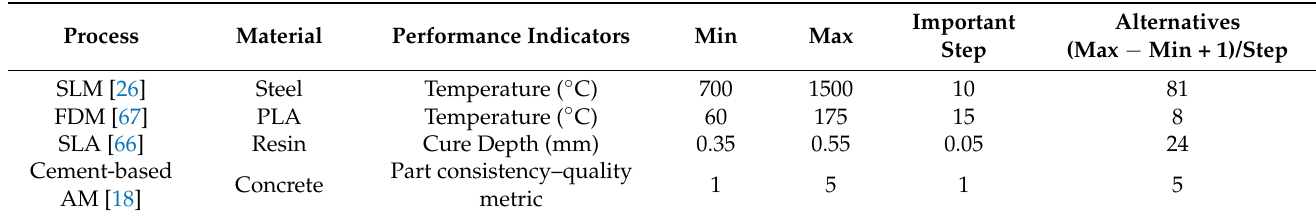
Table 3. Indicative quality key performance indicator (KPI) per process group along with minimum, maximum, important step values and alternatives